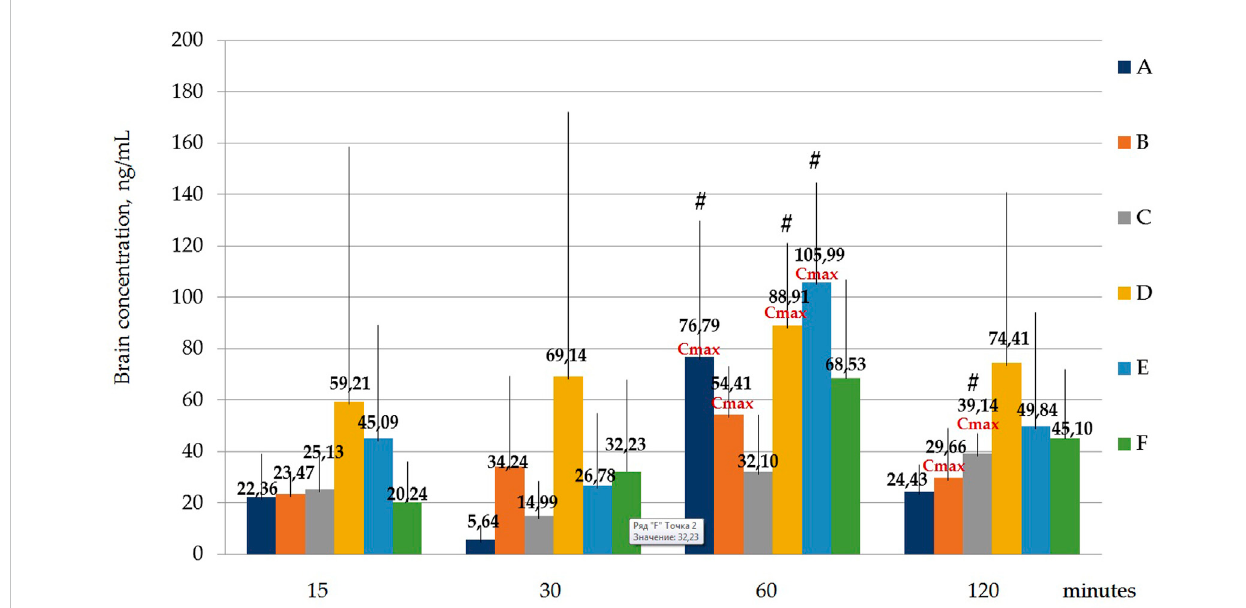
FIGURE 7 Concentration of latrepirdine for polymorphs (A-F) in brain samples. Data are presented as means of all polymorphs at each time point +standard deviation. # — p ≤ 0.05 relative to the “ 30 min ” time point for each Polymorph according to the Kruskal – Wallis test.